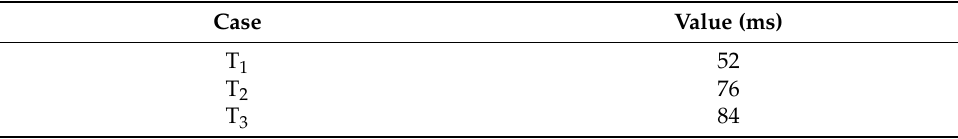
Table 4. The system delay time in different